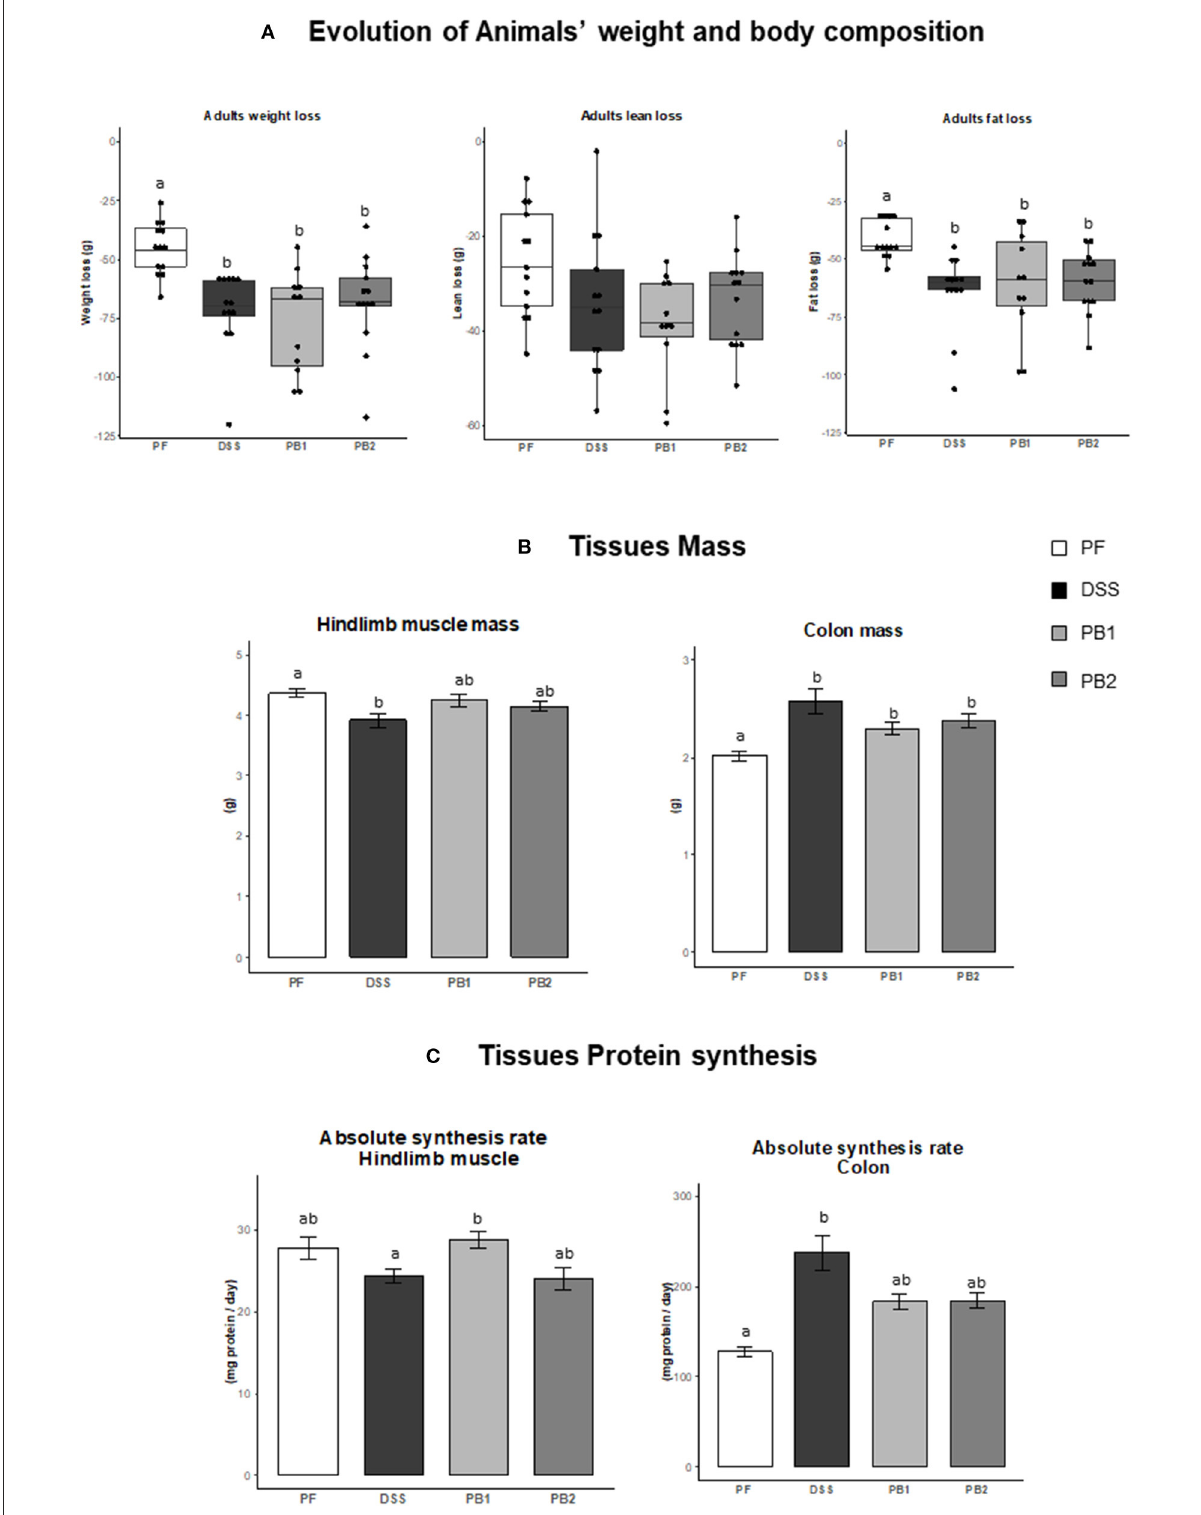
FIGURE1 Impact of Dextran sodium sulfate with (PB1 or PB2) or without (DSS) probiotic supplementation on colon and muscle physiology / metabolism in adult rats. (A) Evolution of rats weight (g), lean mass (g) and fat mass (g), (B) Evolution of hindlimb and colon masses (g), (C) Evolution of